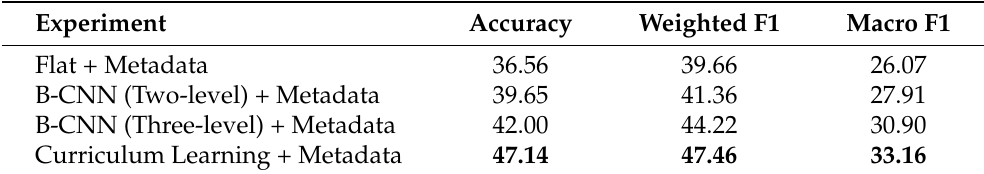
Table 7. Metrics score of test set 1 for the differential diagnosis learning schemes with metadata (in